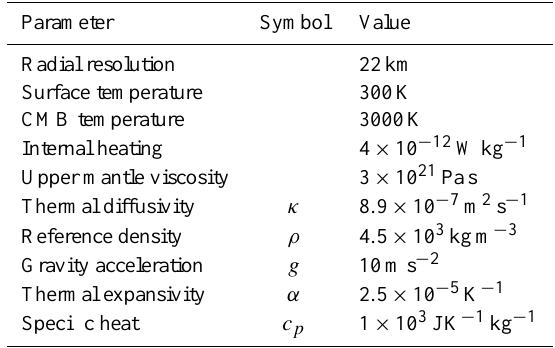
Table 1. Calculation parameters.